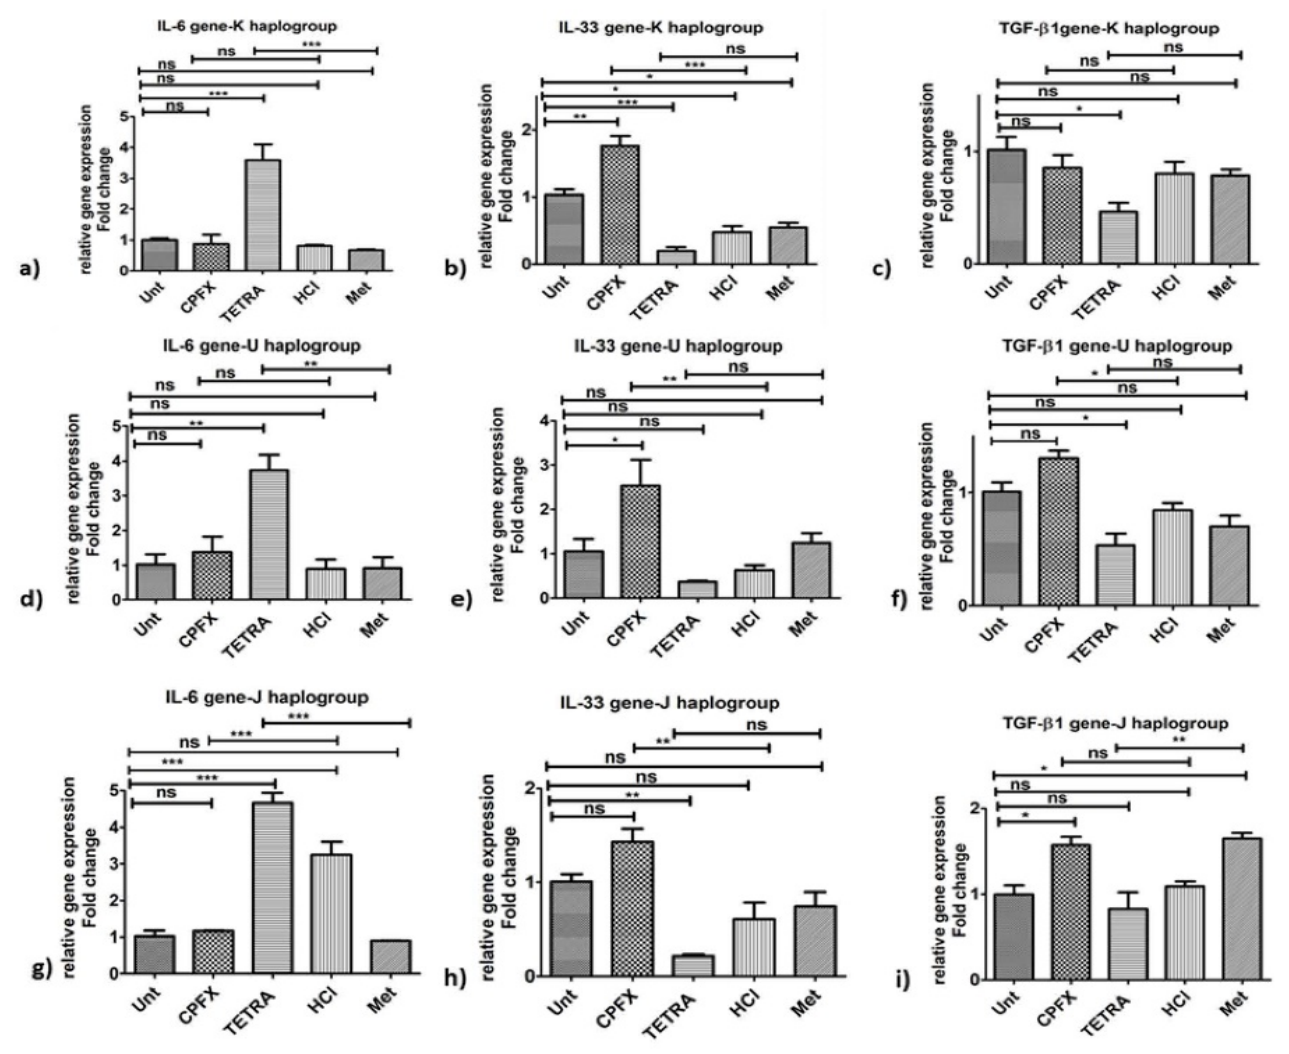
Figure 3. Changes in pro-inflammatory gene expression by CPFX and TETRA in K, U and J cybrids. In K Cybrids, ( a ) overexpression of IL-6 via TETRA, ( b ) higher IL-33 expression via CPFX; ( c ) and higher TGF- β 1 expression via CPFX ( c ). In U cybrids, ( d ) higher IL-6 expression via TETRA, ( e ) higher IL-33 expression via CPFX and ( f ) upregulation of TGF- β 1 via CPFX. In J Cybrids, ( g ) lower expression of IL-6 via CPFX, ( h ) upregulation of IL-33 via CPFX; ( i ) and downregulation of TGF- β 1 via TETRA. (* p < 0.05, ** p < 0.01, *** p < 0.0001).